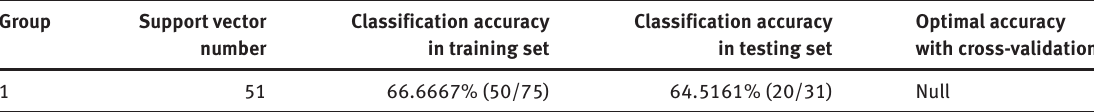
Table 4: The Classification Accuracy in the First Group of Experimental Model. Group